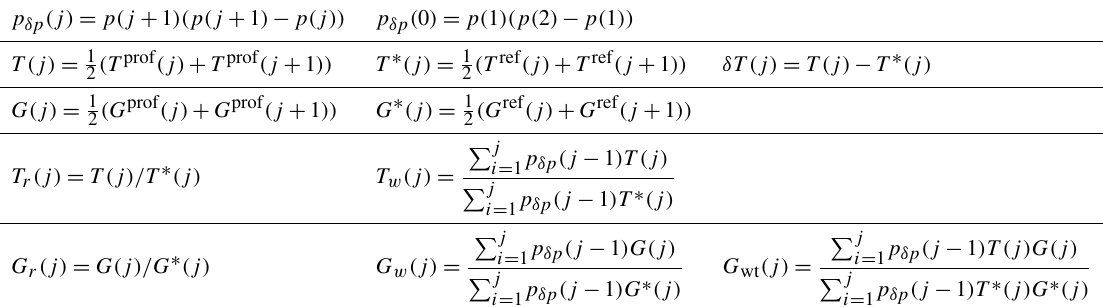
Table A1. Quantities used in predictor calculations listed in Tables A2, A3, and A4.